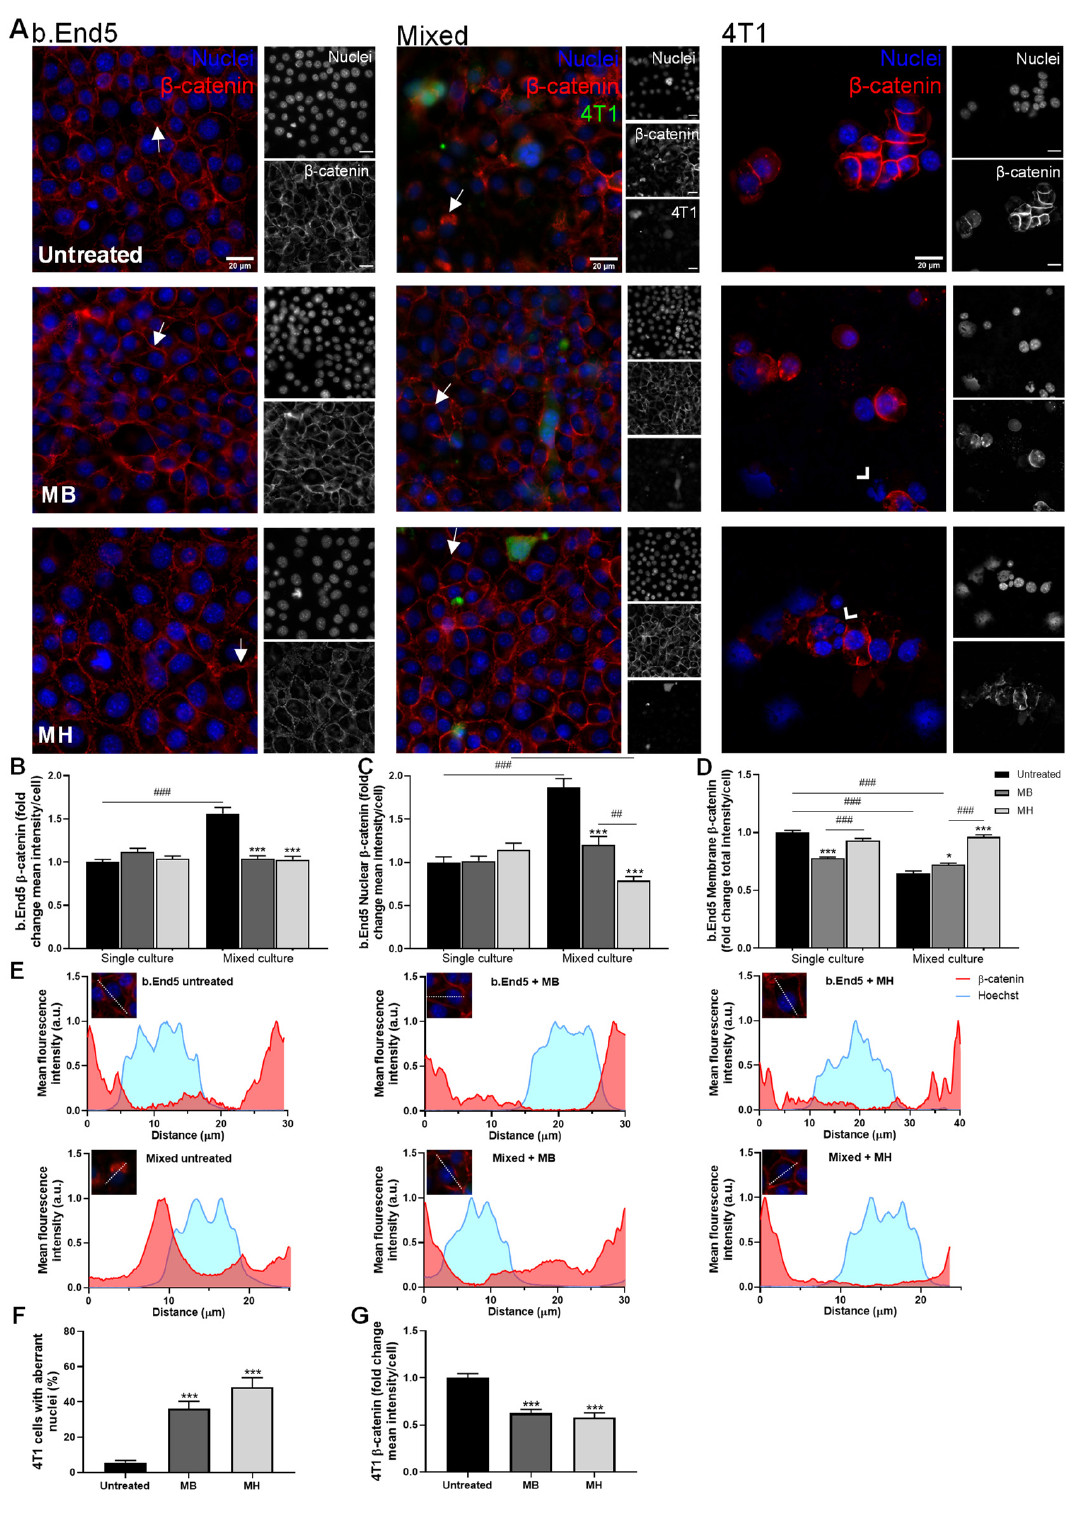
Figure 5. MH induces endothelial barrier properties through the increase in membrane β -catenin expression. Confluent monolayers of b.End5 cells under physiological laminar non-pulsatile shear stress were exposed to 4T1 cells (previously labelled with CellTracker™ CMFDA Green Dye) and treated with MB or MH (1 µM), or DMEM (untreated), for 24 h and the expression of the AJs protein β -catenin (red) in single and mixed cultures was evaluated by immunofluorescence analysis. Hoechst 33342 was used as counterstaining for nuclei (blue). Scale bar: 20 µm. ( A ) Treatment with MB and MH induced an increase in β -catenin expression in endothelial cells exposed to 4T1 cells, particularly at cell membrane (white arrows), and an increase in 4T1 cells with aberrant nuclei (white arrow heads). Semi-quantitative analysis of endothelial β -catenin ( B ) mean intensity per cell, ( C ) nuclear intensity, and especially ( D ) membrane intensity confirmed the observations. ( E ) The